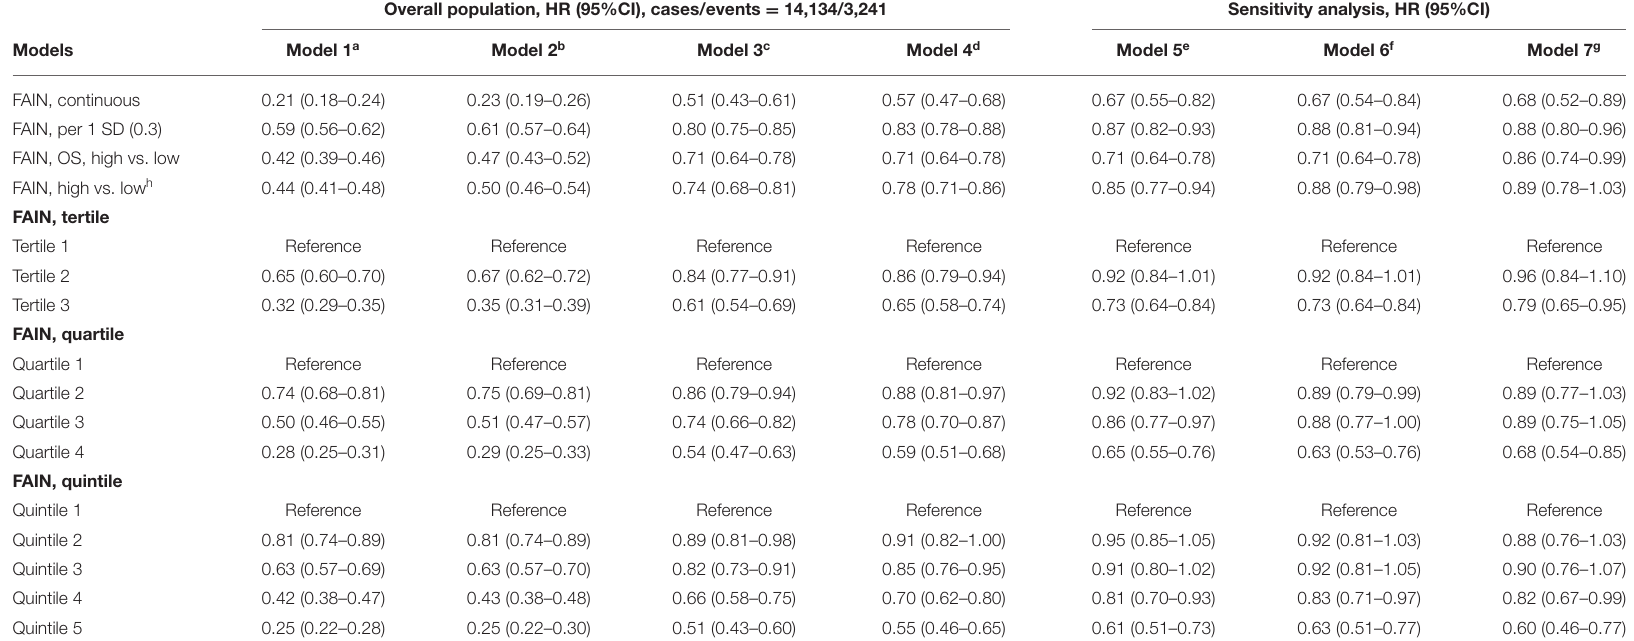
TABLE 3 | Multivariable models for the FAIN and overall survival. Overall population, HR (95%CI), cases/events =